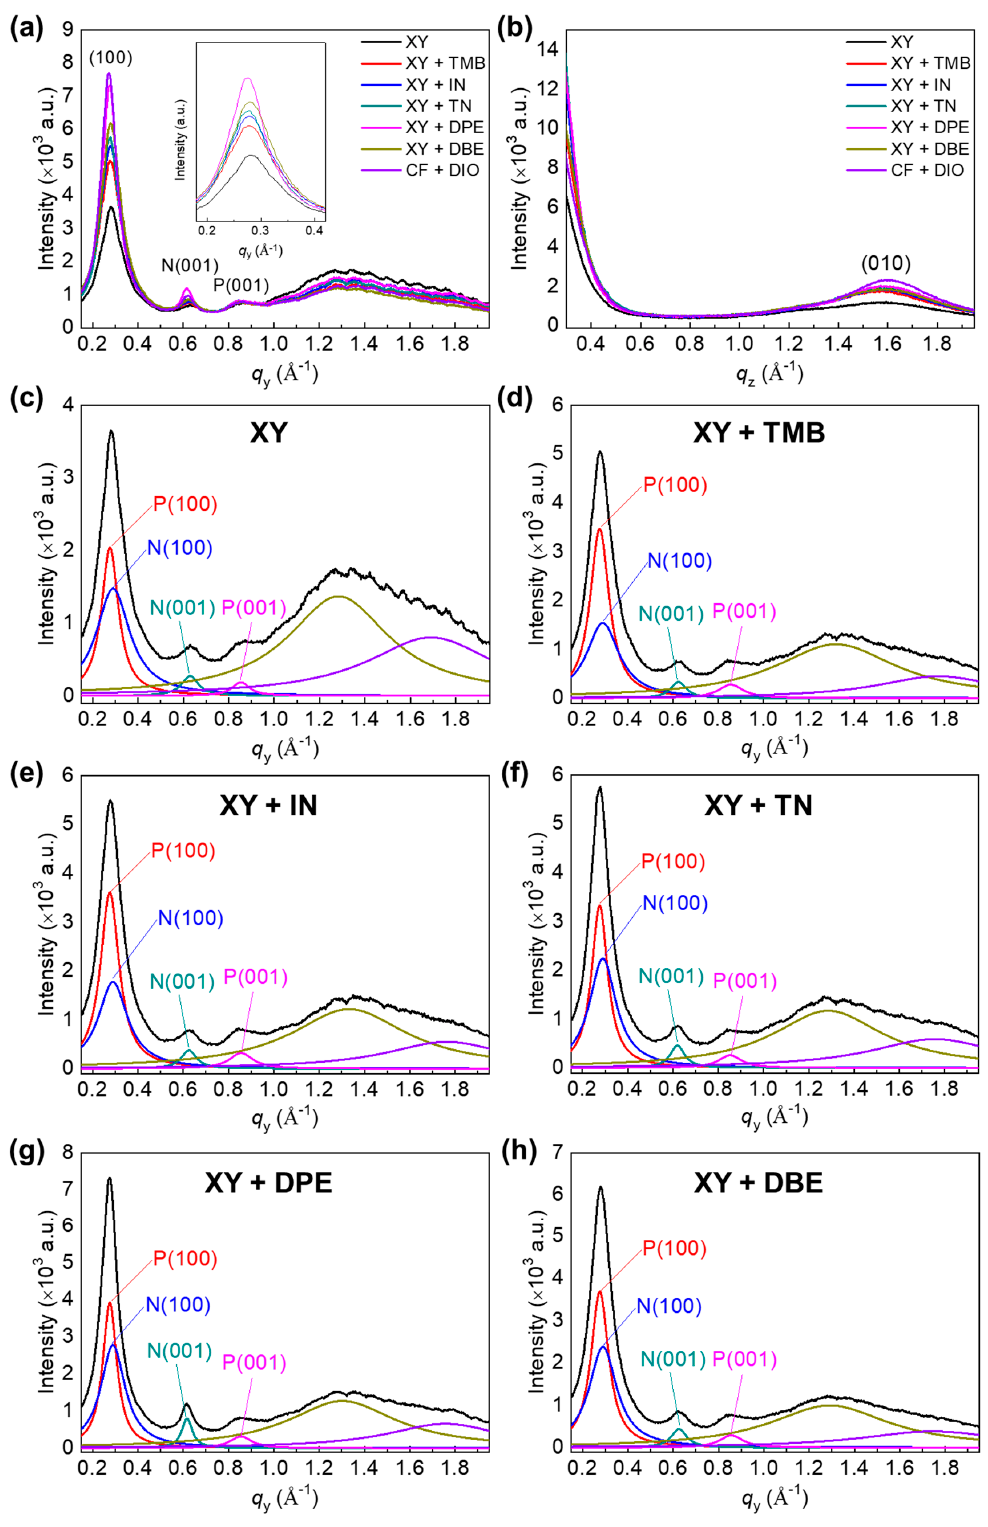
Figure 9. ( a ) In-plane line cuts and ( b ) out-of-plane line cuts of GIXD images in the blend films. Each in-plane line cut with fitted lines of ( c ) XY-, ( d ) XY + TMB-, ( e ) XY + IN-, ( f ) XY + TN-, ( g ) XY + DPE-, and ( h ) XY + DBE-based blend films. Raw data were fitted with the Lorentzian function. P and N indicate the PTB7-Th and PNDI2HD-T polymers,